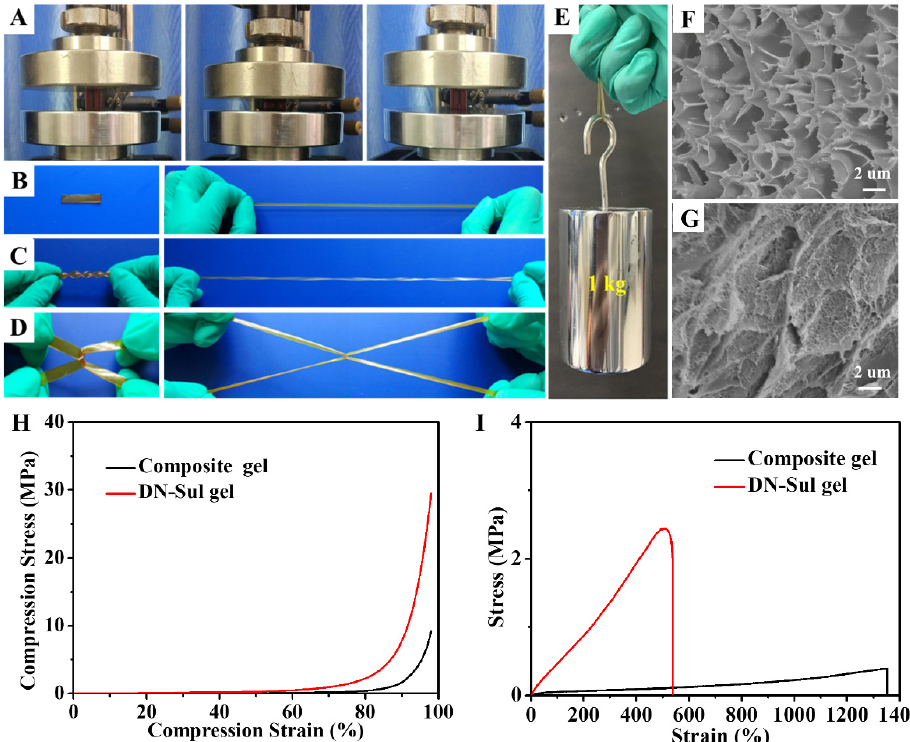
Figure 2. The mechanical properties of the DN hydrogel. ( A ) Compression, ( B ) stretching, ( C ) twisting–stretching, and ( D ) crossing–stretching. ( E ) Load-bearing ability (loading weight: 1 kg). SEM images of ( F ) the composite hydrogel and ( G ) the DN hydrogel. ( H ) Compressive and ( I ) tensile curves of the composite and DN hydrogels.